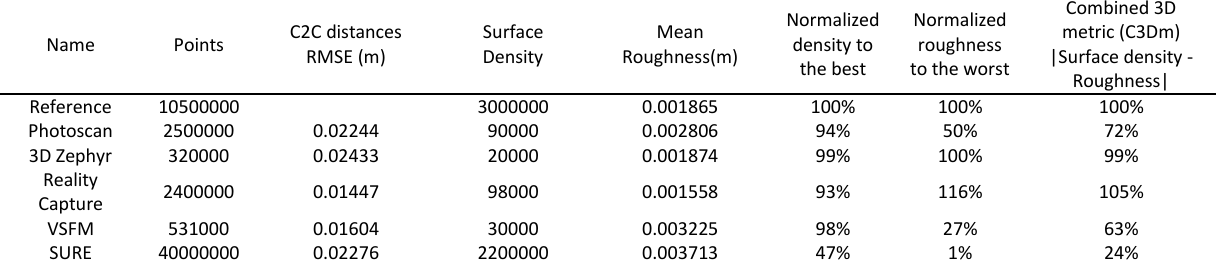
Table 2: Combined 3D metric (C3Dm) of the surface density and Roughness of the point clouds the 5 different packages